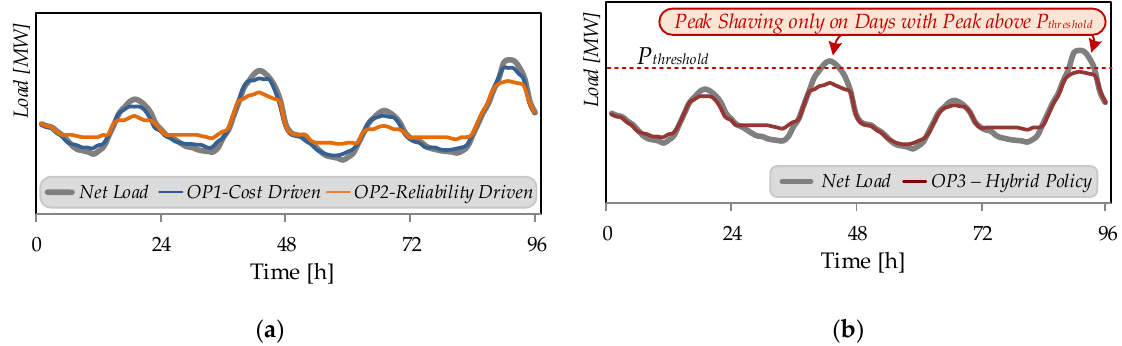
Figure 1. Daily load curve shaping for over an indicative 4-day period with the implementation of the alternative policies: ( a ) OP1 vs. OP2; ( b ) OP3.